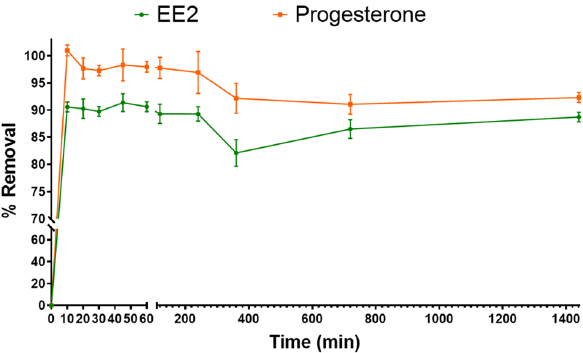
Figure 2. Removal efficiency over time of 17α-ethinylestradiol (EE2) and progesterone.